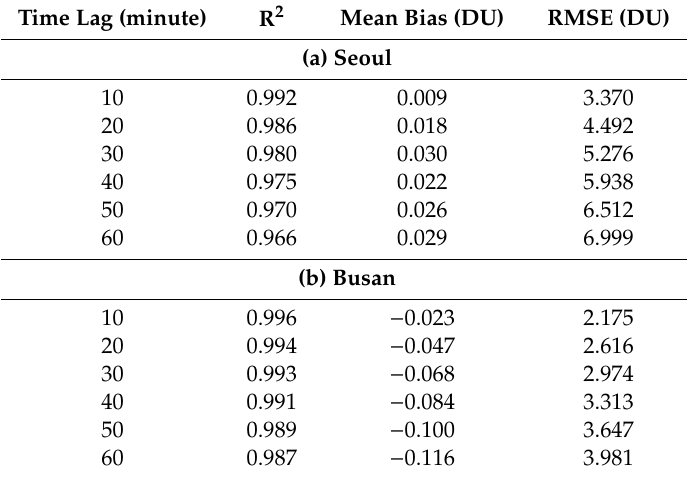
Table 3. Statistical results for temporal variability of total column amount of ozone (TCO) with time lag change in ( a ) Seoul and ( b ) Busan. Time Lag (minute) R 2 Mean Bias (DU) RMSE